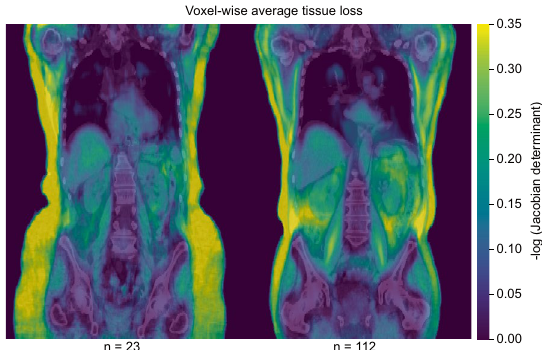
Figure 6. Average tissue loss between pre- and post-therapy CT scans derived from between- and within- subject registration of head and neck cancer patients. Mid-coronal planes are shown overlaid in color on the chosen female (left) and male (right) template CTs. The number of subjects in each subset is shown below the